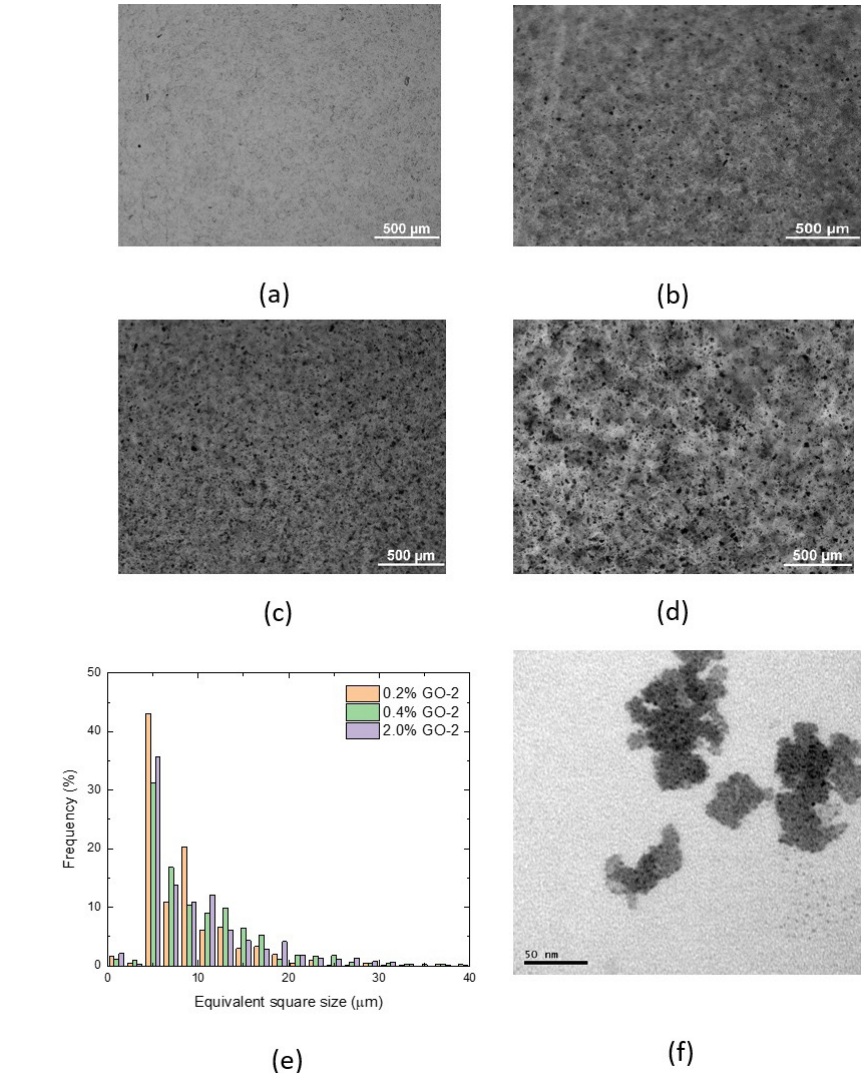
Figure 11. PCU and PCU + GO-2 composites morphological characterizations. Optical microscopy: (a) PCU; (b) PCU + 0.2%GO-2; (c) PCU + 0.4%GO-2 and (d) PCU + 2.0%GO-2; (e) Equivalent square size histogramas of nancomposites. Transmission electron microscopy image: (e) PCU + 2.0%GO2, marked with osmium